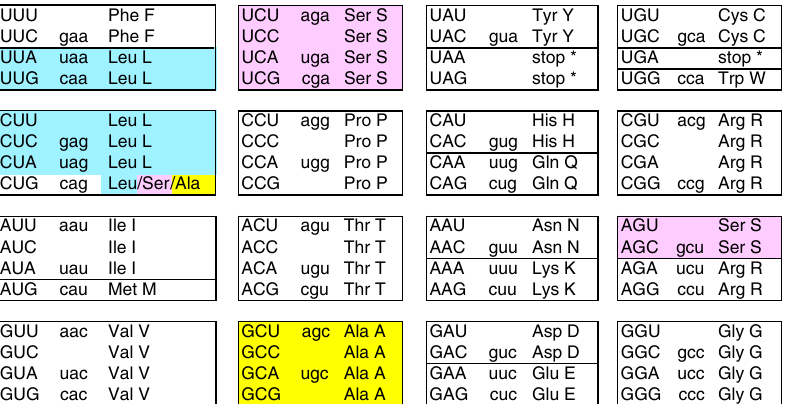
Fig. 1 The genetic code. CUG is translated as Leu in the standard code, and as Ser or Ala in the modi fi ed codes. Codons are shown in uppercase. The anticodon set of Saccharomyces cerevisiae is shown in lowercase, as is tRNA CAG , which is not present in S.